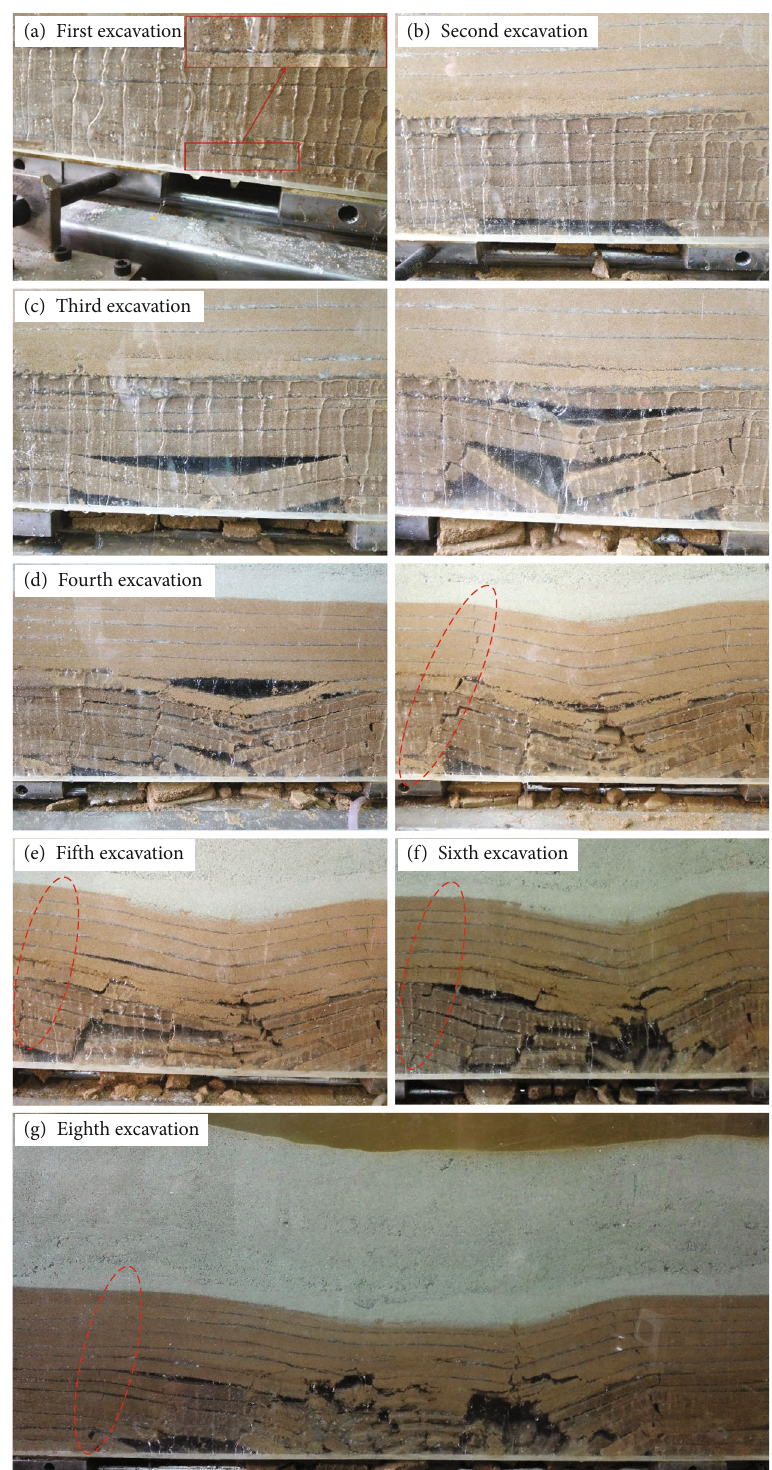
Figure 11: Deformation and failure of overlying